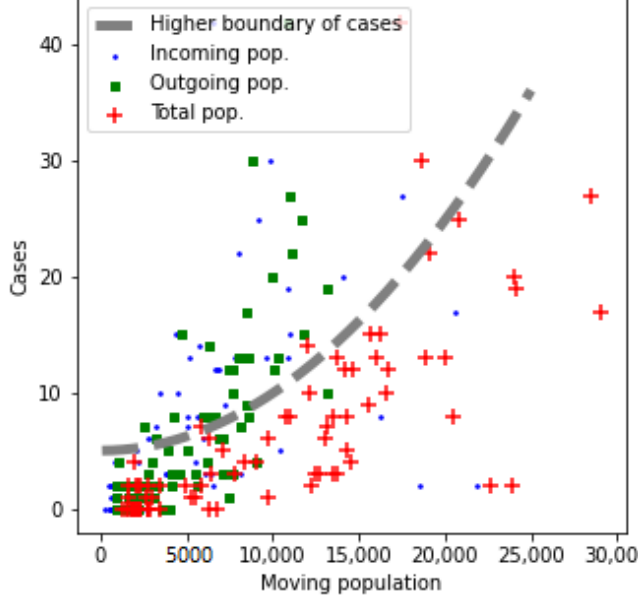
Figure 5. Number of cases vs.